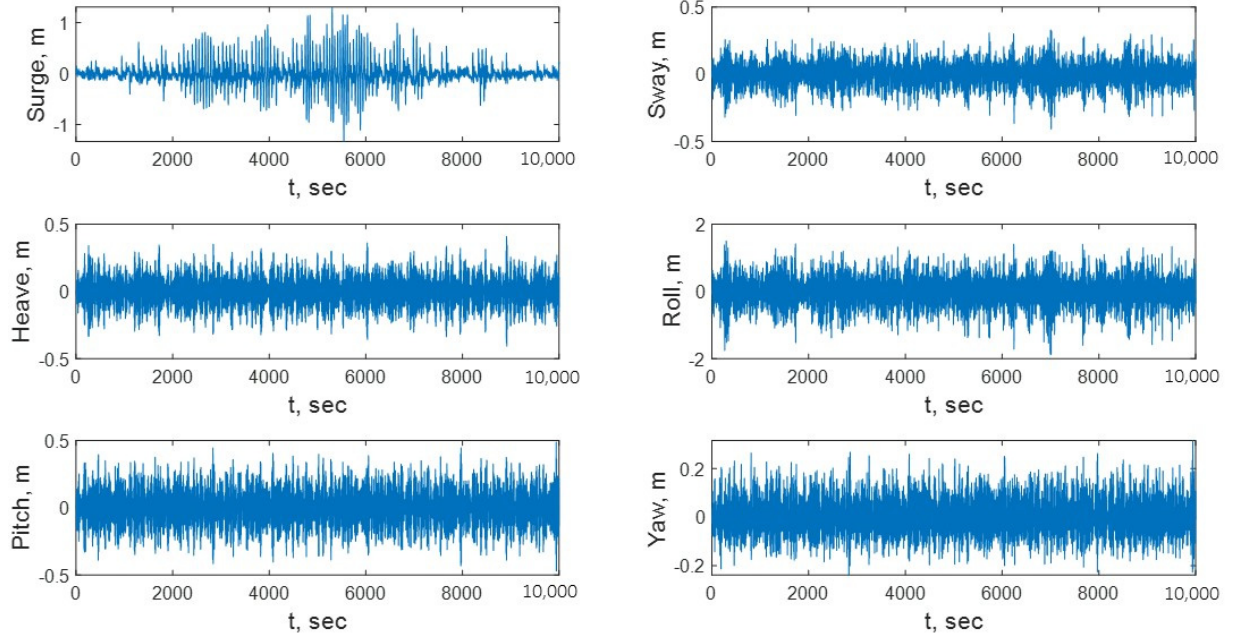
Figure 9. Load case s2 H mo = 2.5 m—wave frequency position. The surge and sway position are relative to the position of the Delta, the rest are absolute position of the ship .